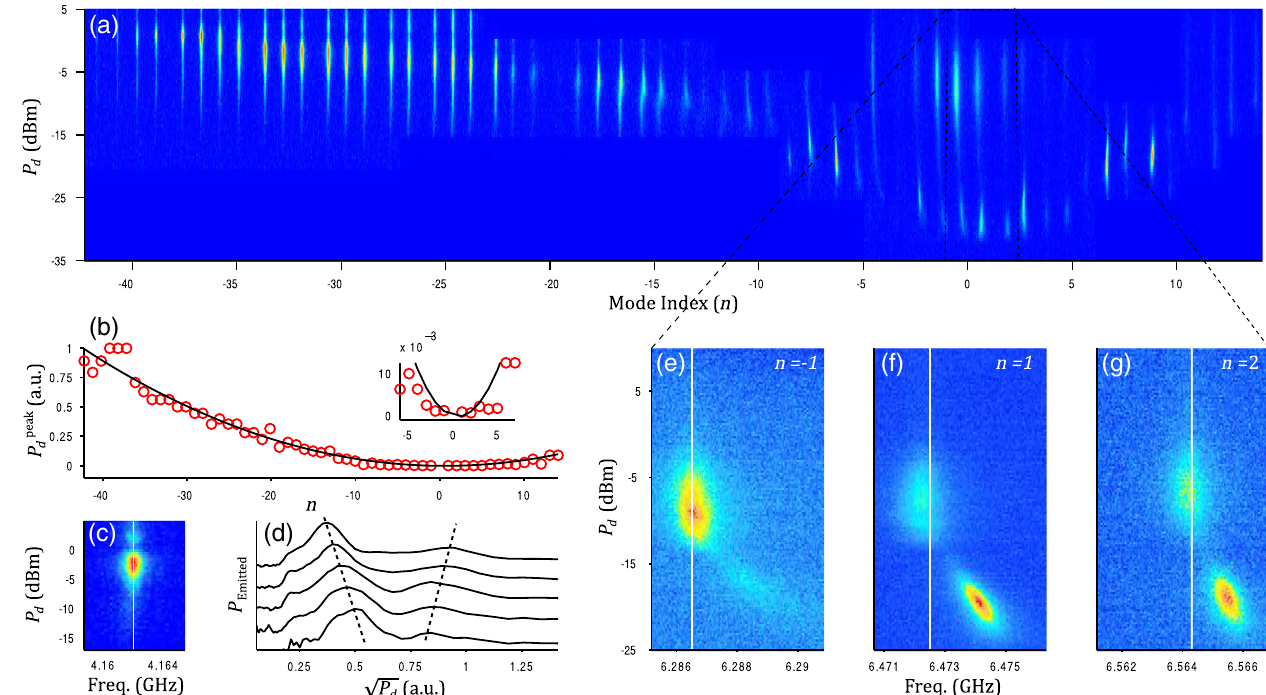
¼ ω ¼ ω FIG. 3. Multimode resonance fluorescence. (a) Power spectrum for varying drive power P , when ω 74 , measured at more d d a than 50 modes. Mode index n is the relative detuning from the drive mode n ¼ m − 74 . Power is measured in a 10-MHz window around each mode, excluding the driven mode ( n ¼ 0 ). Increasing drive power unveils fluorescence at farther-detuned modes, strong emission from multiphoton processes, and complex multilobed fluorescence spectra. (b) The drive power corresponding to peak fluorescence for each far-detuned mode shows a quadratic dependence on detuning, suggesting this fluorescence is due to cavity-enhanced sideband fluorescence [9]. Modes near the drive frequency (see the inset) do not follow the quadratic fit due to strong multimode interaction. (c) Detailed plot of n ¼ − 30 from (a) shows a multilobed structure in fluorescence spectrum. Bare mode frequency is denoted with a ¼ ω ¼ ω vertical white line. For (d) – (g), ω 68 . (d) We explore the difference between the two lobes seen in (c) for several modes d a ( n ¼ − 36 , − 34 , − 32 , − 30 , − 28 , from bottom to top with individual curves vertically displaced for clarity) by measuring the total fluorescence power in a 6-MHz window while varying drive power. The drive powers corresponding to peak fluorescence move oppositely with mode number for the two lobes. (e) – (g) For modes near the drive ( n ¼ − 1 ; 1 ; 2 ), strong multimode interaction further yields a more complex multilobed structure. Bare cavity-mode frequencies are denoted with vertical white